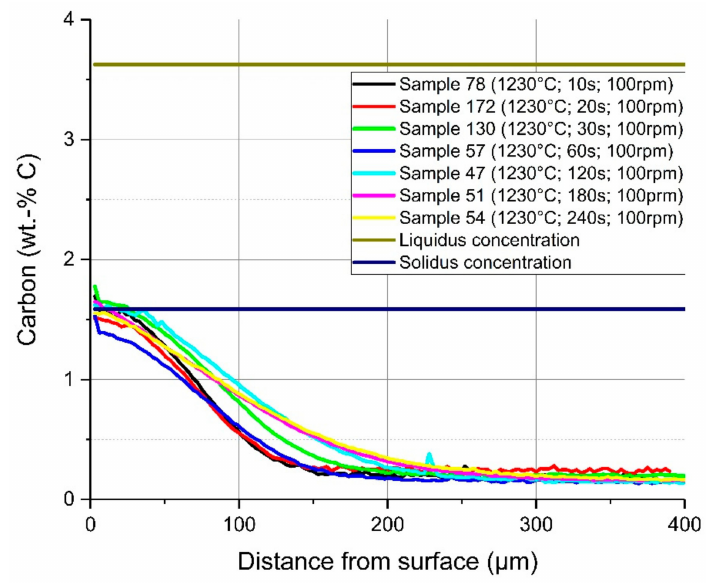
Figure 12. Average carbon composition and di ff usion depth from the detected solid–liquid interface under forced convection in the melt through rotation of the sample at 1230 ◦ C equilibrium